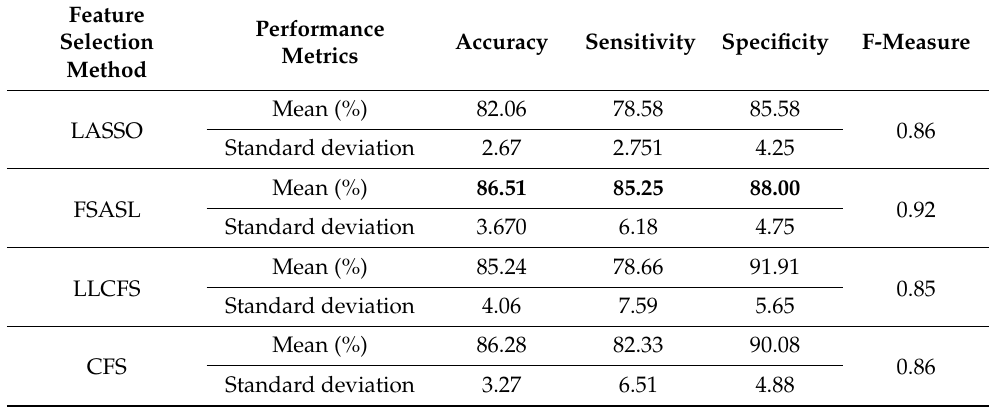
Table 2. Classification performance for AD against HC using SL-RELM classifier on whole brain network using different feature selection methods.